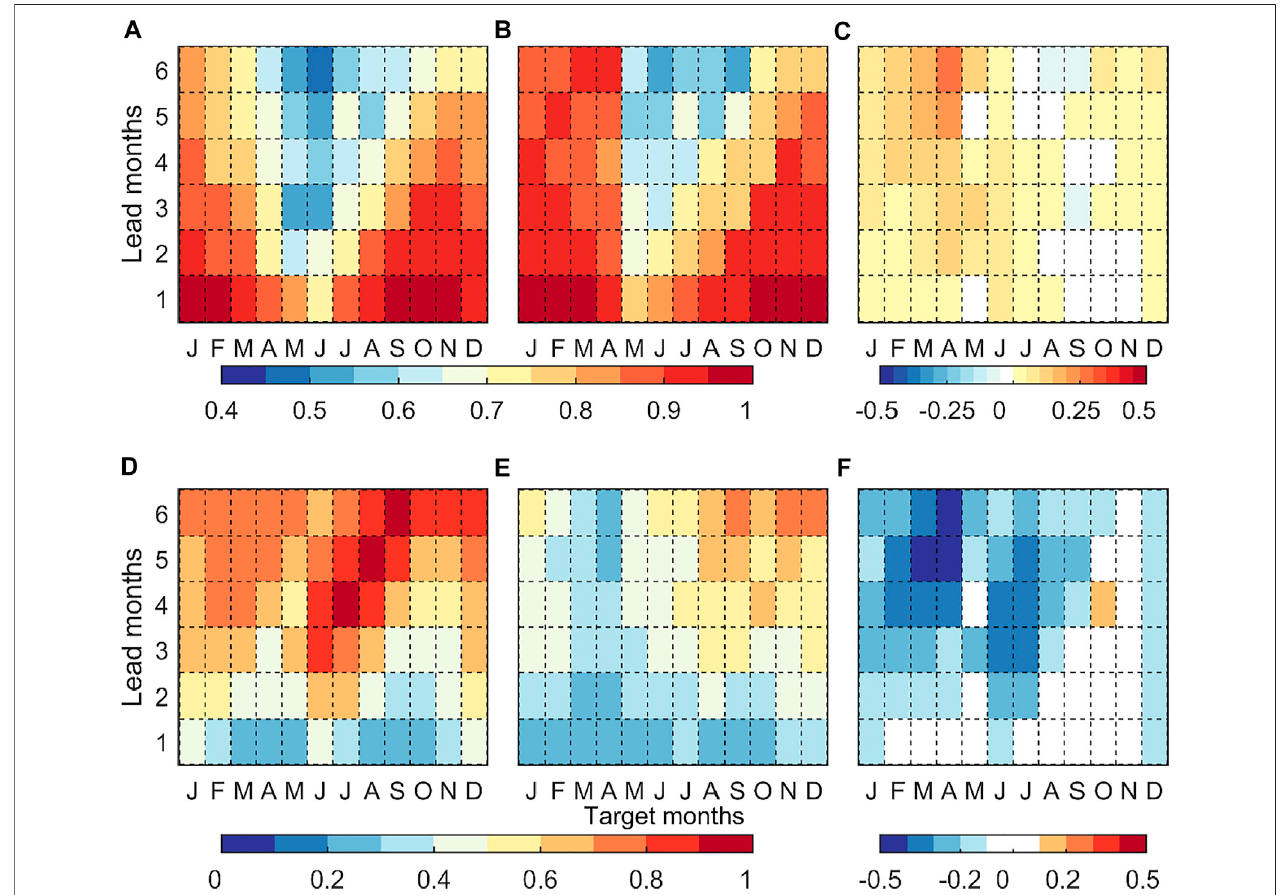
FIGURE 5 | ACC and RMSE of the Niño 3.4 SSTA as a function of the target month and lead month obtained using the (A,D) FIO-CPS v1.0; (B,E) FIO-CPS v2.0; (C,F) the differences between FIO-CPS v2.0 and FIO-CPS v1.0.